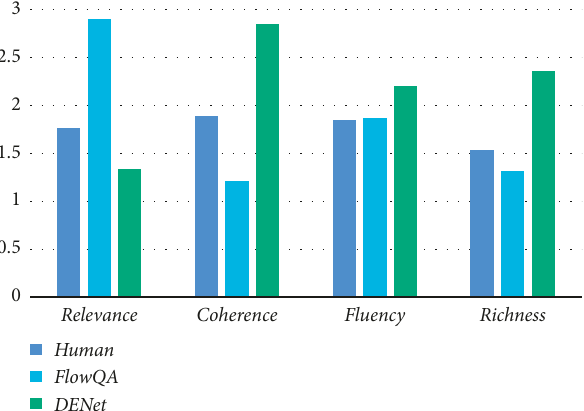
Figure 6: Feature extraction model